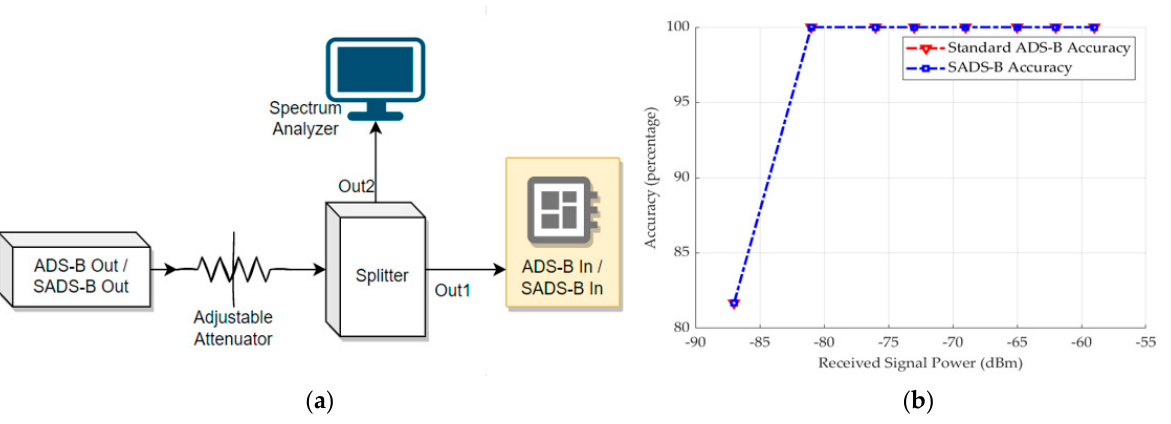
Table 2. Mean value of computational time of standard ADS-B and SADS-B in Simulink and